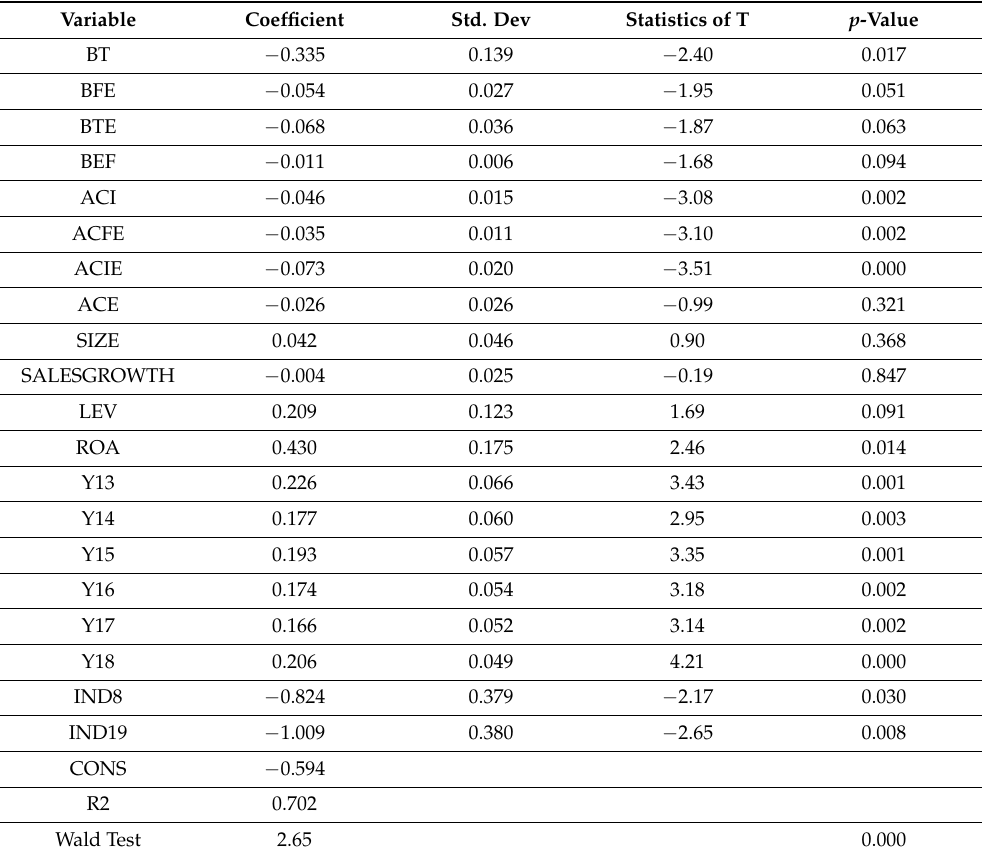
Table 14. The results of estimating the first model by the method of fixed